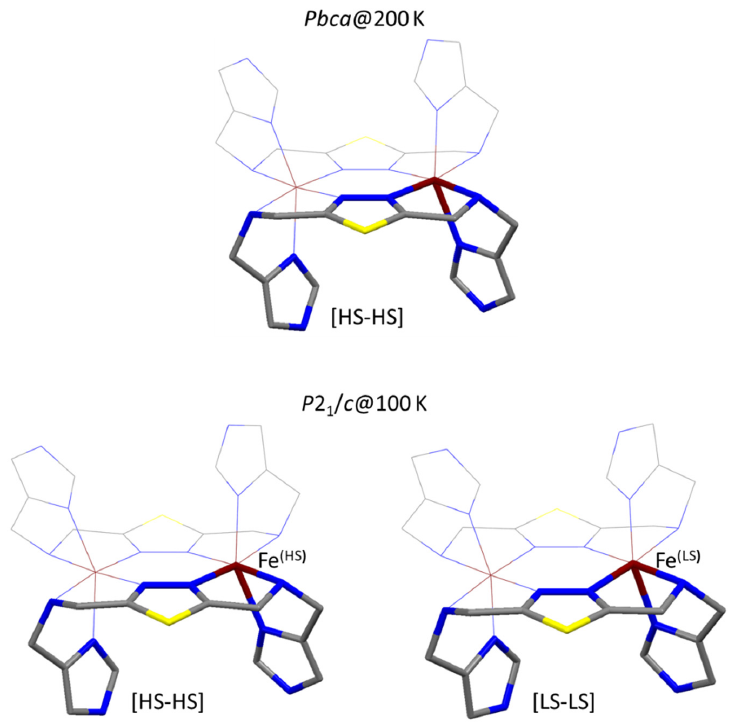
Figure 3. Crystallographic independent complex cations for C3 ·THF at 200 (top) and 100 K (bottom). The asymmetric units are depicted in bold, while the second half of the cations (wireframe) are symmetry generated. The orientation of the molecules and the labeling is the same as for Figure 2. Hydrogens, solvent molecules and cations are omitted for clarity. Color code: Fe dark red, N blue, S yellow, C gray.